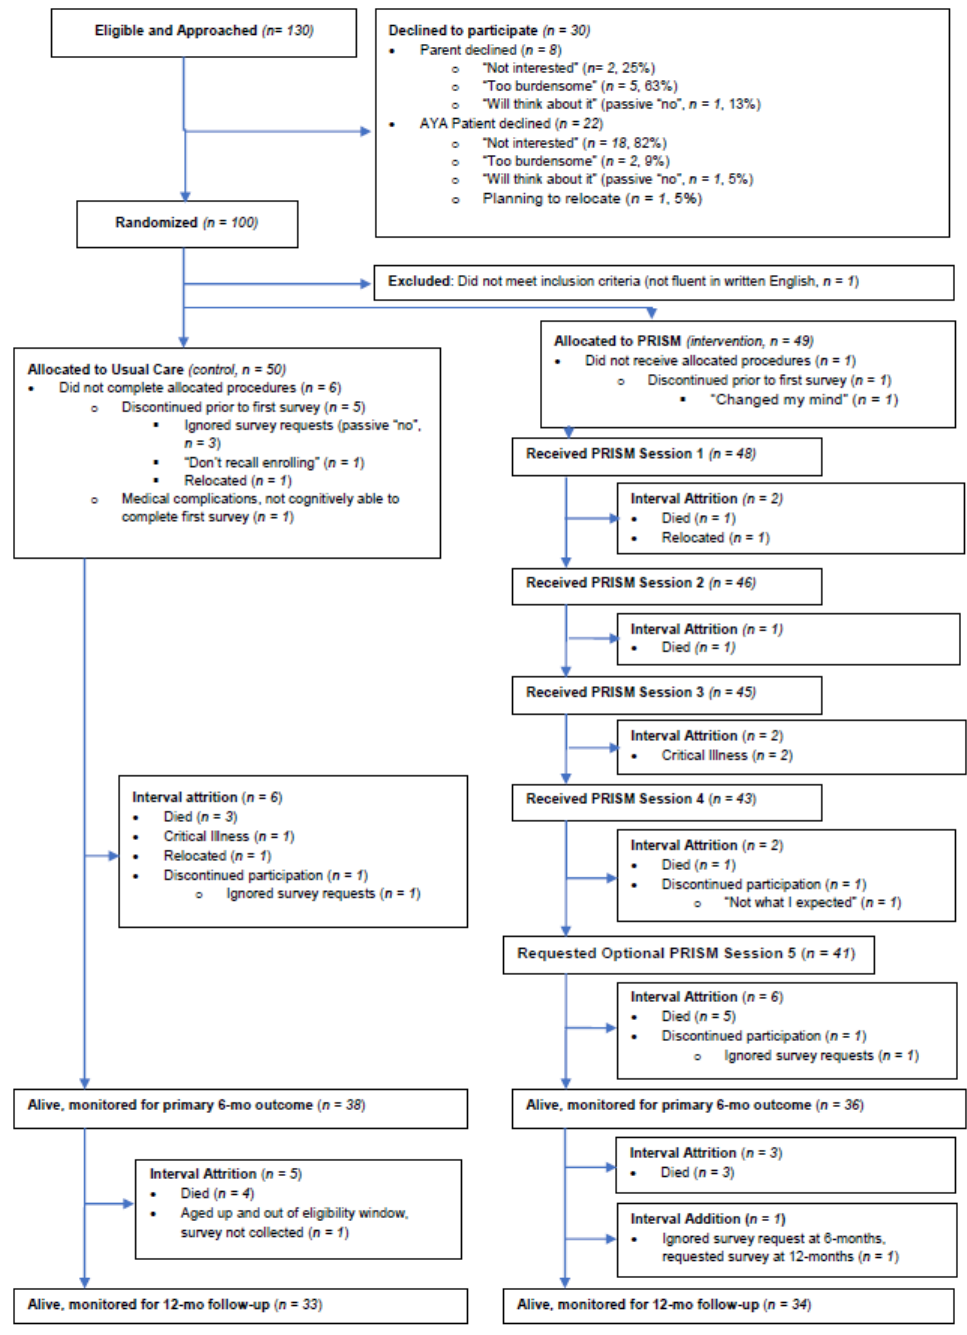
Figure 1. Flow of screening, approach, enrollment, and attrition during the course of the Promoting Resilience in Stress Management (PRISM) randomized trial.